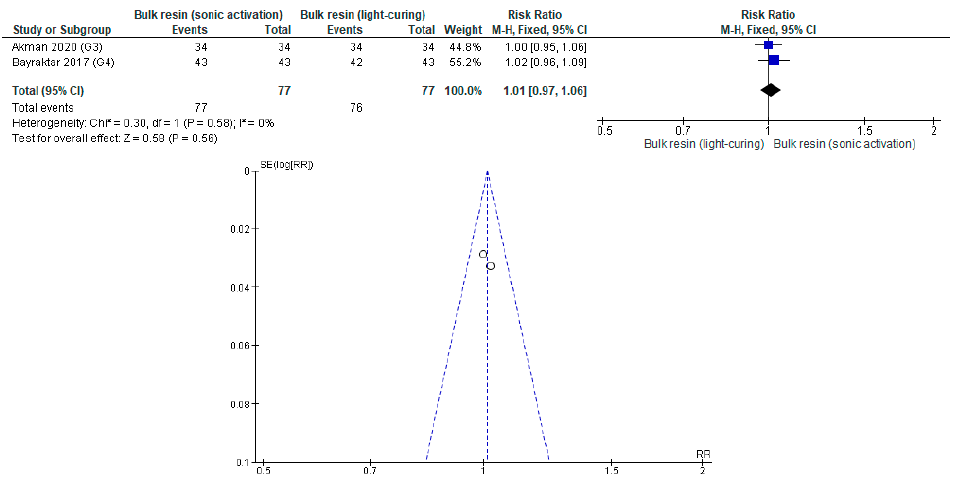
Figure A39. Proper Anatomical Form: Bulk Resin (with Sonic Activation) versus Bulk Resin (Two-Step Technique).